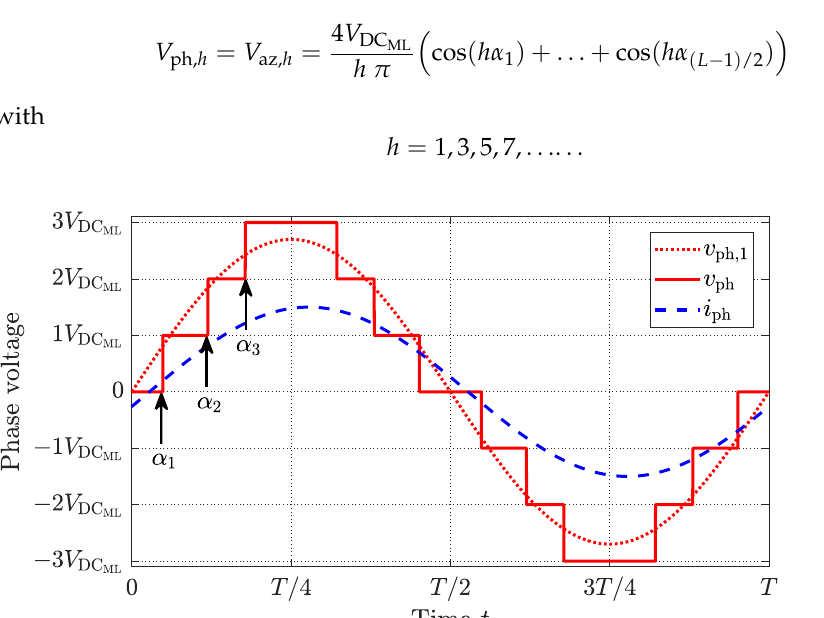
Figure 5. Output voltage modulation using FSHE for M =